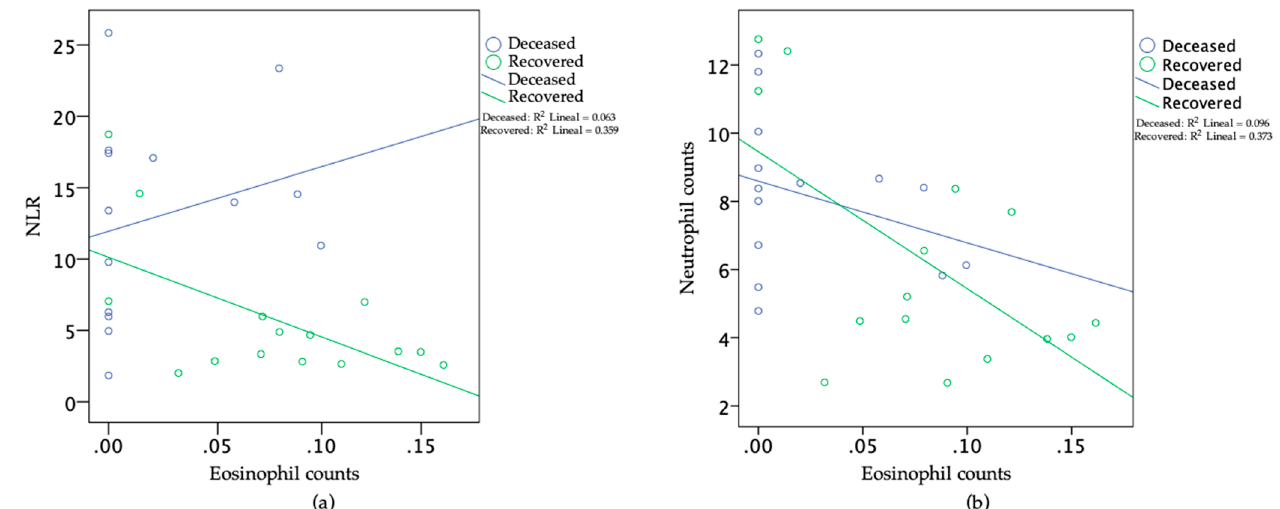
Figure 4. Kaplan–Meier survival function from the time of admission to the time of death in COVID- 19 patients with eosinopenia (eosinophil counts < 0.01 × 10 9 /L) and without eosinopenia at Day 9 of onset of clinical symptoms. The probability of survival was within a period of 3 to 57 Days—that is, the period in which the cohort of COVID-19 patients analyzed remained hospitalized. Recovered patients ( n = 15); deceased patients ( n = 14).